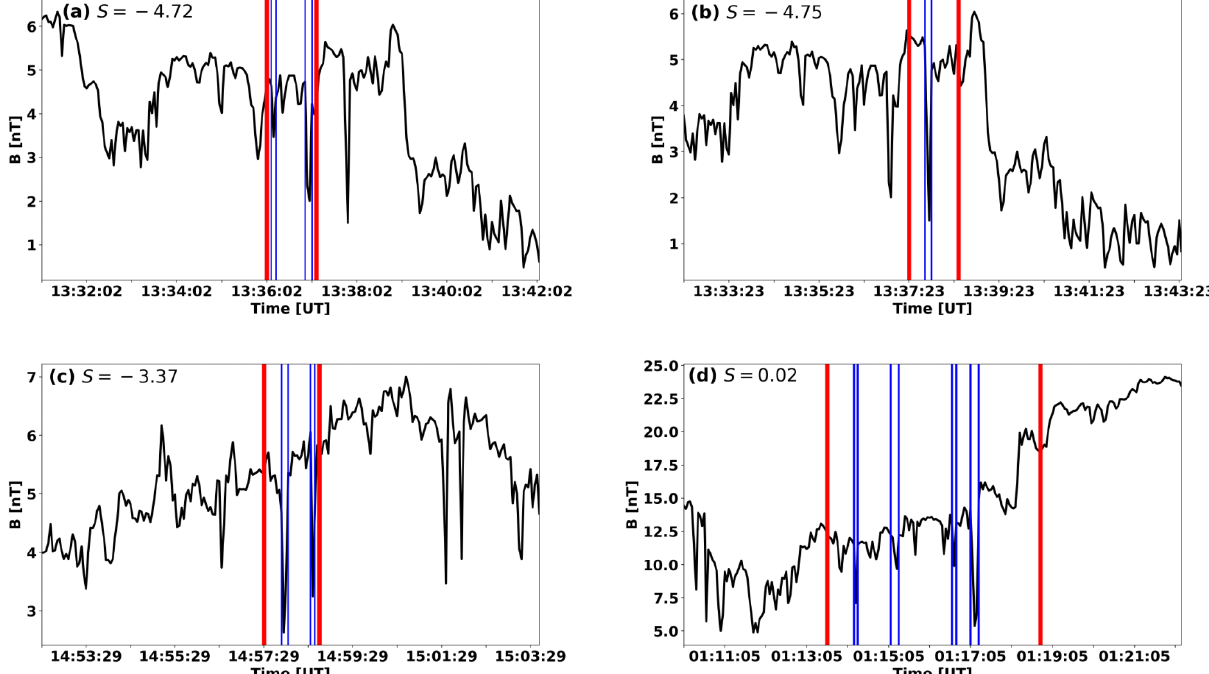
Figure 1. Examples of individual mirror modes (MMs) in ICME-driven sheath regions. The shock preceding the ICME passed the Wind spacecraft at 11:10UT on 16 April 1999 ( a–c ) and at 18:30UT on 29 May 2003 ( d ). The investigated intervals are bounded by the red vertical lines and the detected MMs are the structures limited by the blue vertical lines. The skewness ( S ) of the investigated interval is given in each panel. The angular changes in the magnetic field direction over the MM structures (from left to right) are (a) 1.1 and 2.7 ◦ , (b) 2.3 ◦ , (c) 6.7 and 4.4 ◦ , and (d) 6.1, 3.2, 1.7 and 4.5 ◦